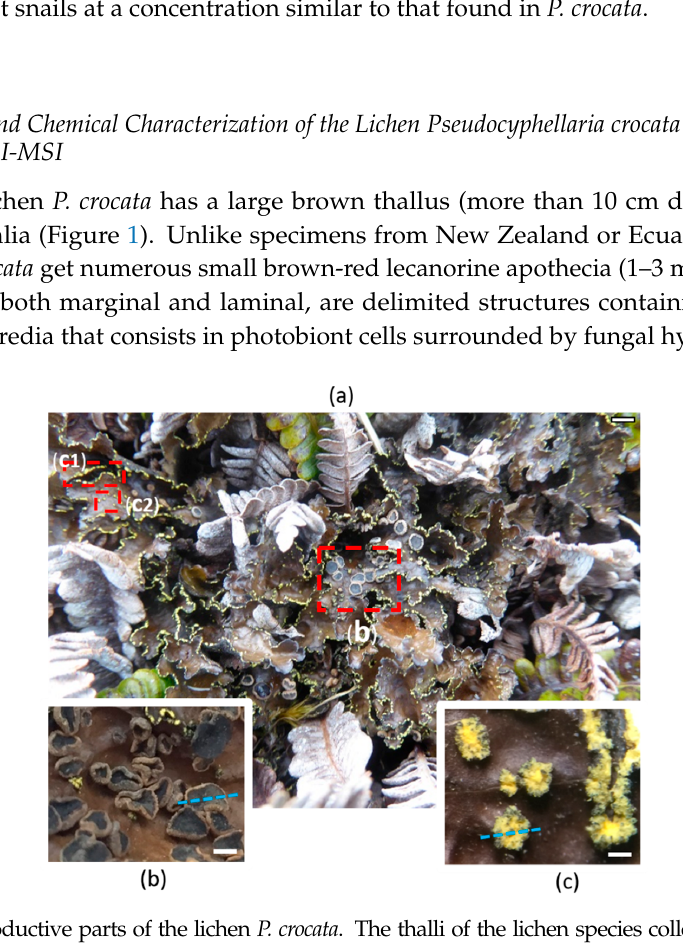
Figure 1. Reproductive parts of the lichen P. crocata . The thalli of the lichen species collected on the fern Blechnum penna-marina ( a ). Insets correspond to the sexual reproductive parts apothecia ( b ) and asexual reproductive part soralia ( c ) which are marginal ( c1 ) and laminal ( c2 ). Blue lines allow visualization of the cross sections for MSI experiments. Scales bars correspond to 1 cm, 500 µm, and 100 µm in panels (a–c), respectively.